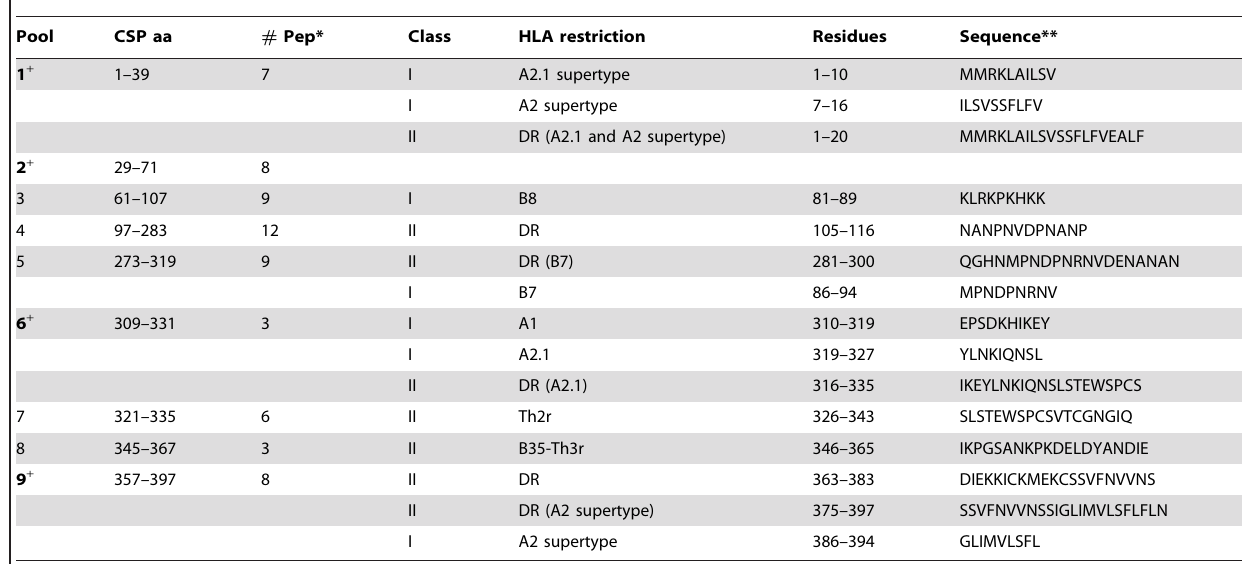
Table 2. CSP peptides used in ELISpot and ICS assays.